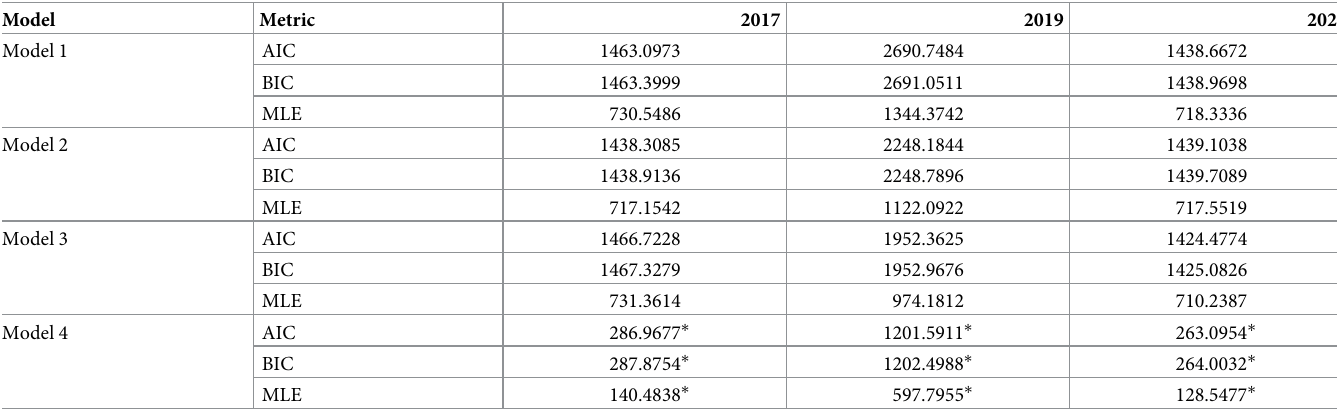
Table 3. Evaluation of the model fits using AIC , BIC , and MLE .